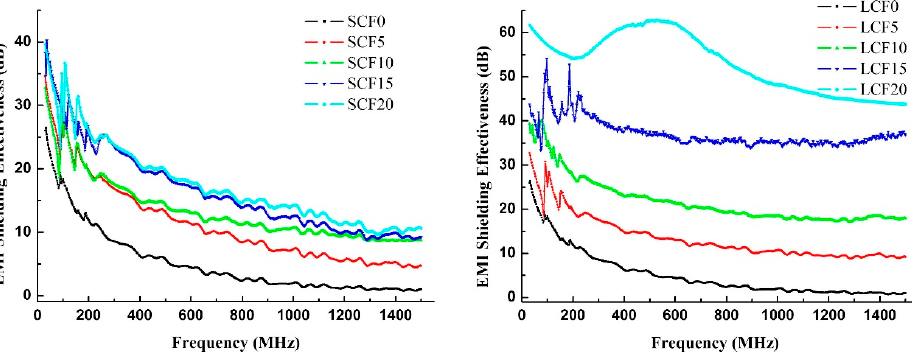
Figure 4. Electrical resistivity for the composite foams as the function of carbon fiber content.